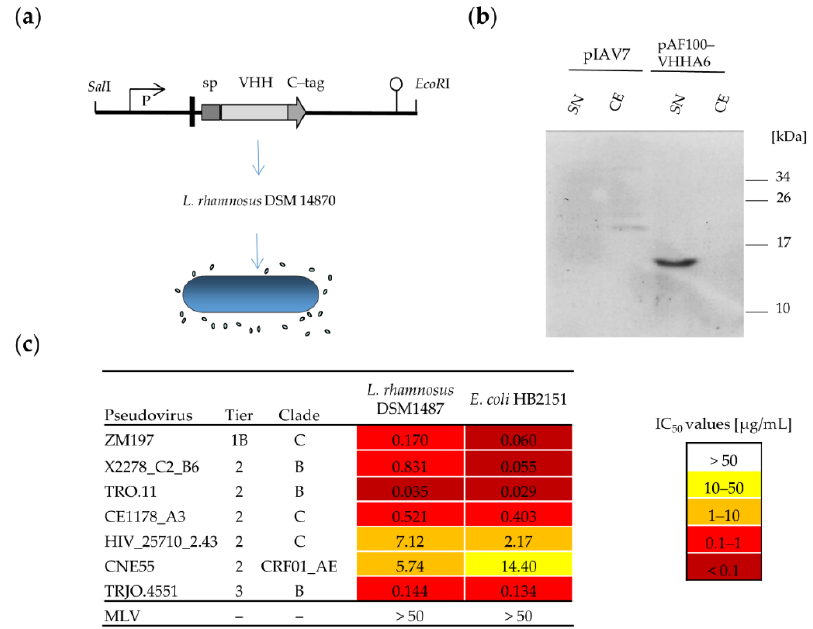
Figure 3. Expression of secreted VHHA6 from Lactobacillus rhamnosus DSM 14870 pAF100-VHHA6.